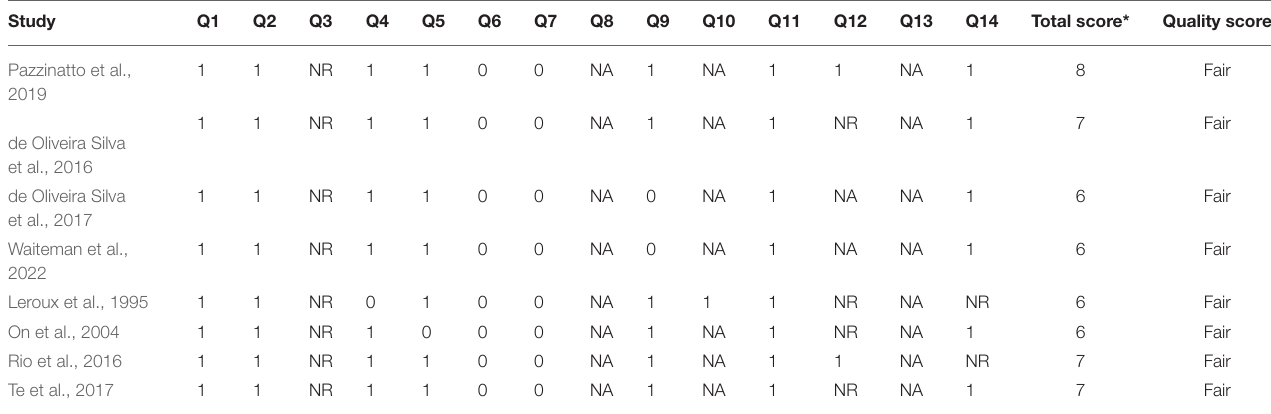
TABLE 2 | Quality assessment of the articles using the National Institutes of Health Quality Assessment Tool for Observational Cohort and Cross Sectional Studies.